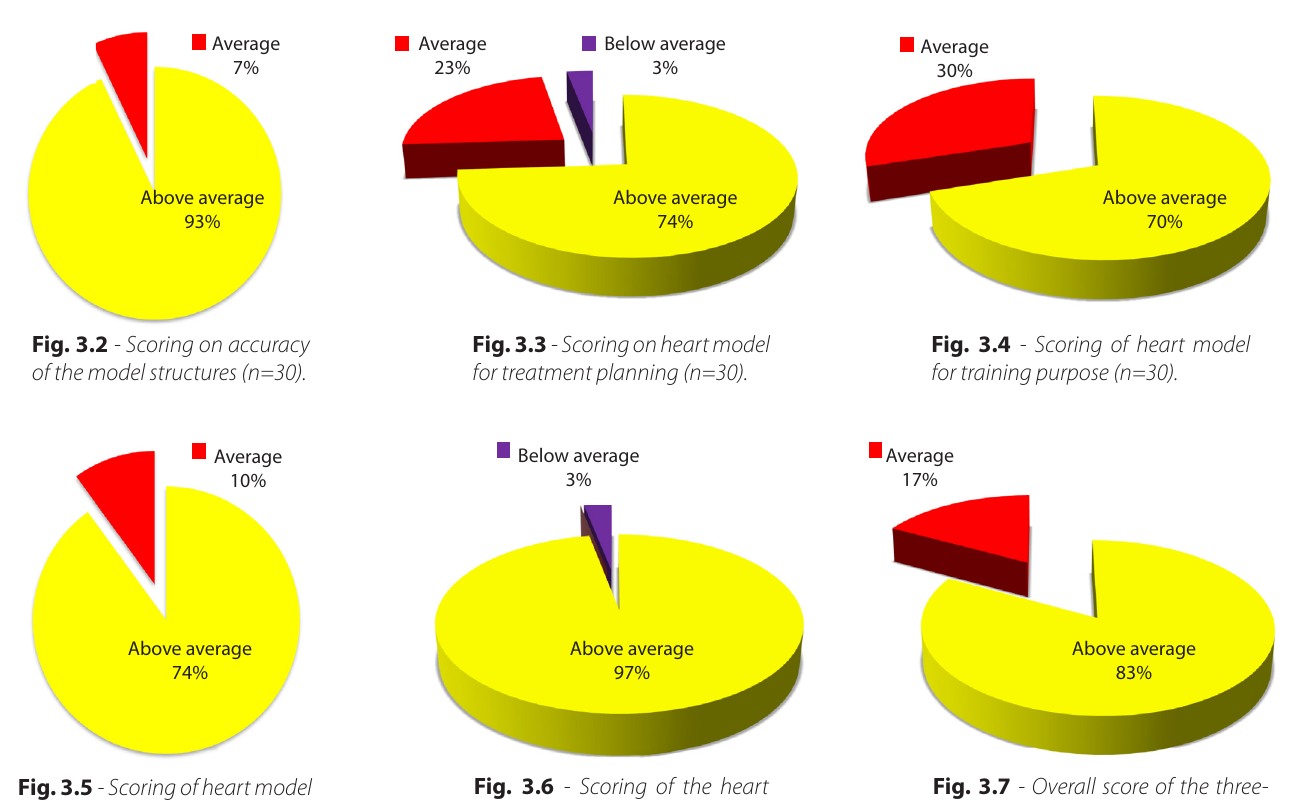
Fig. 3.5 - Scoring of heart model as a surgical visual aid.